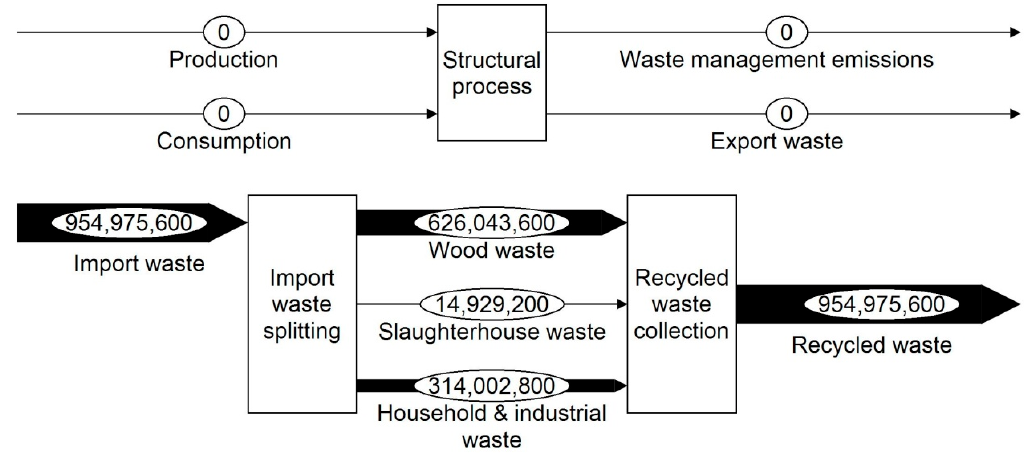
Figure A10. Energy flows of Karlskoga combined heat and power plant, subsystem waste management.